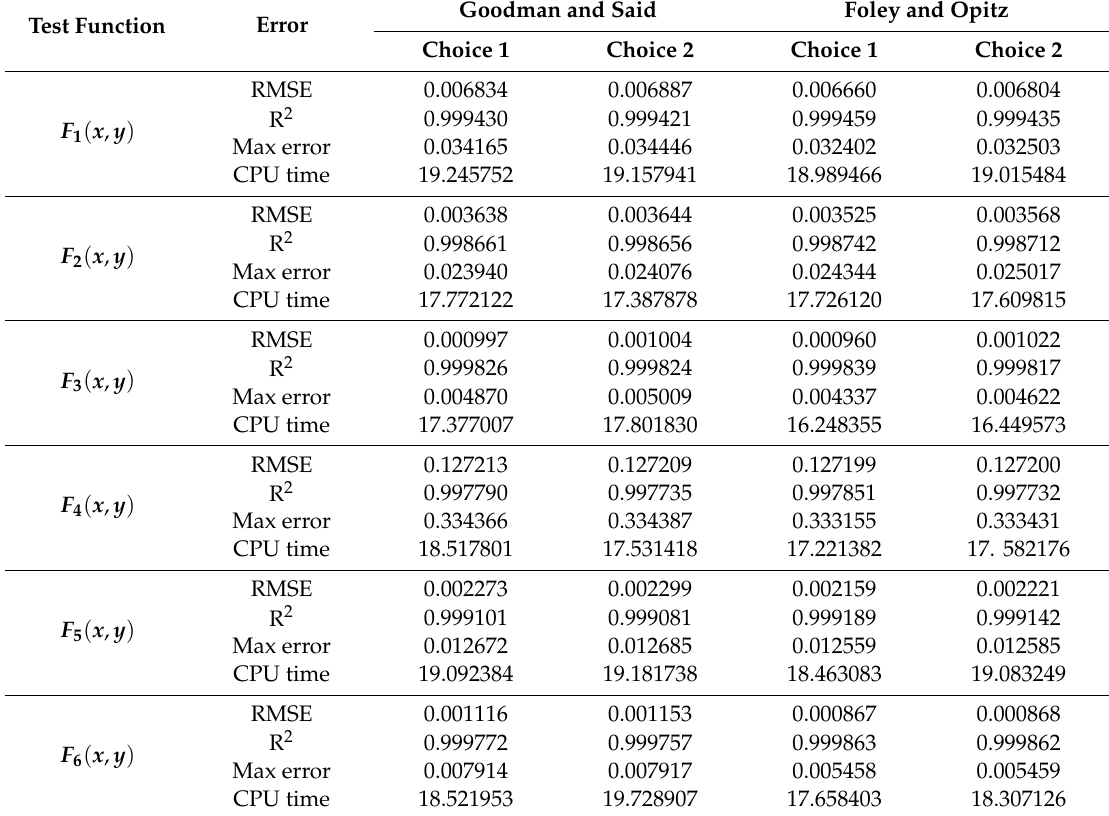
Table 7. Error analysis for 100